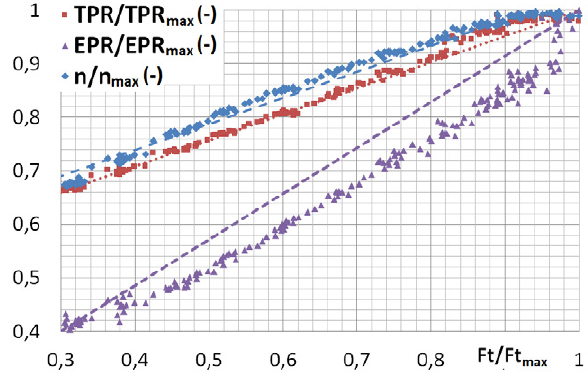
Figure 3. Comparison of different thrust parameters throughout the entire operating range